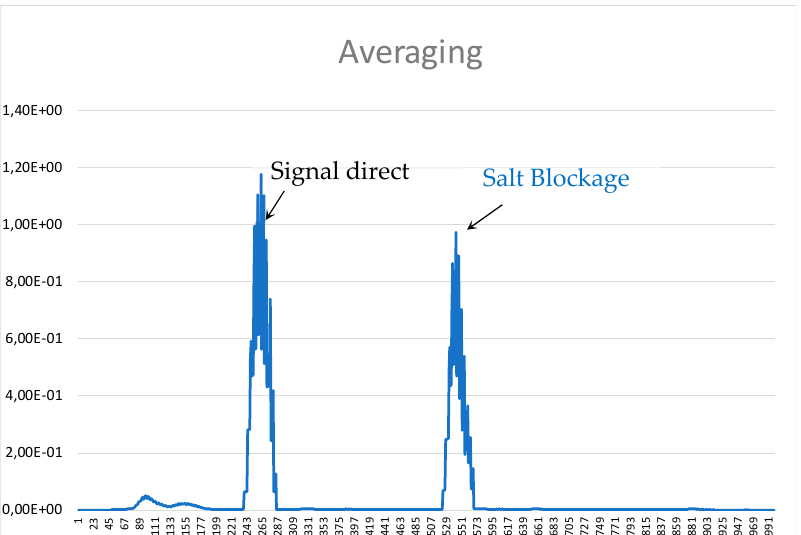
Figure 23. Signal obtained from the wavelet transformation post-processing.